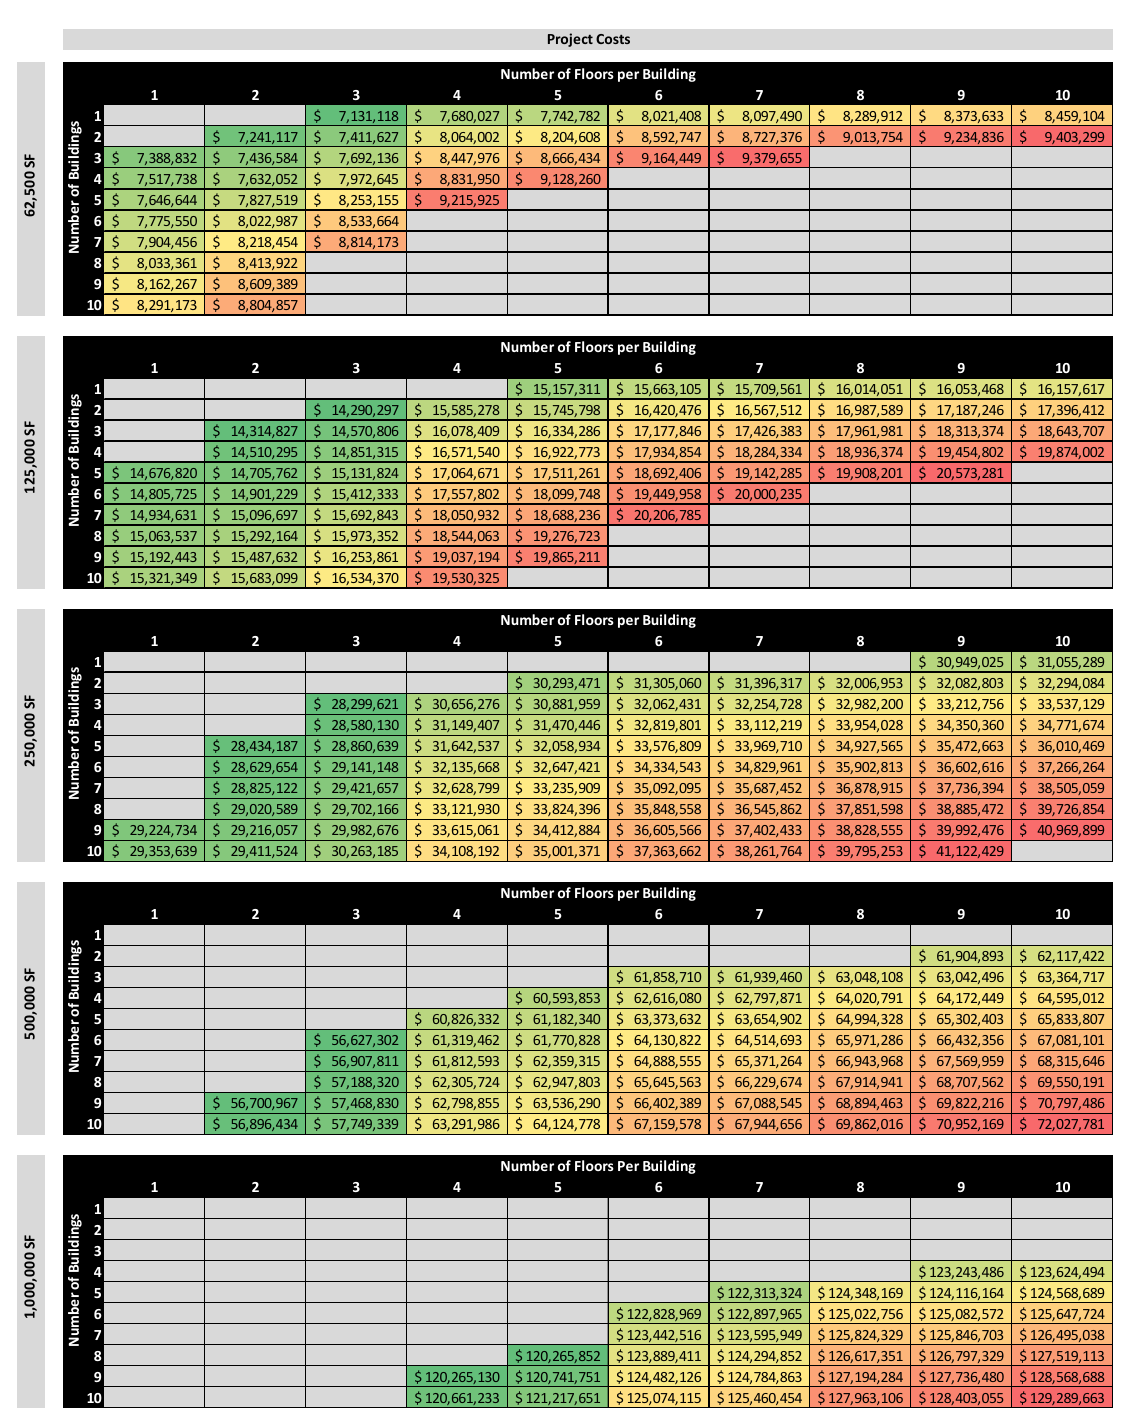
Figure 11. Cost by Number of Buildings and Building Height.